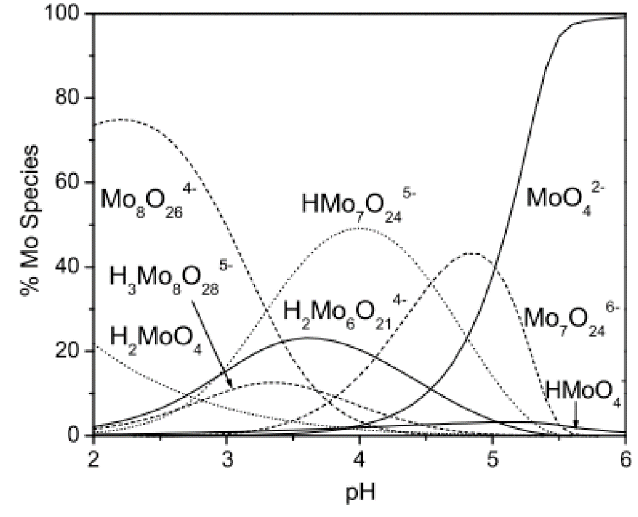
Figure 15. Speciation of Mo ions in water [60].